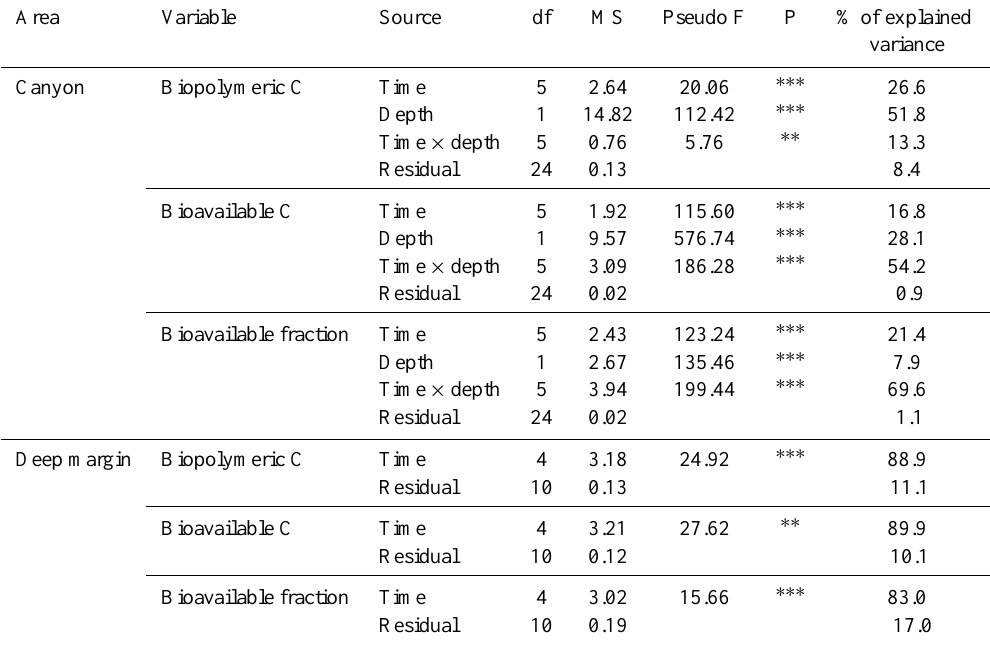
Table 2. Results of the PERMANOVA tests on the quantity and bioavailability of biopolymeric C in the sediments of the Cap de Creus Canyon and deep margin. Also reported is the percentage of variance explained by each source of variation and their interaction. df = degrees of freedom; MS = means square; F = statistic F; P = probability level. ∗∗∗ = P < 0.001; ∗∗ = P < 0.01.